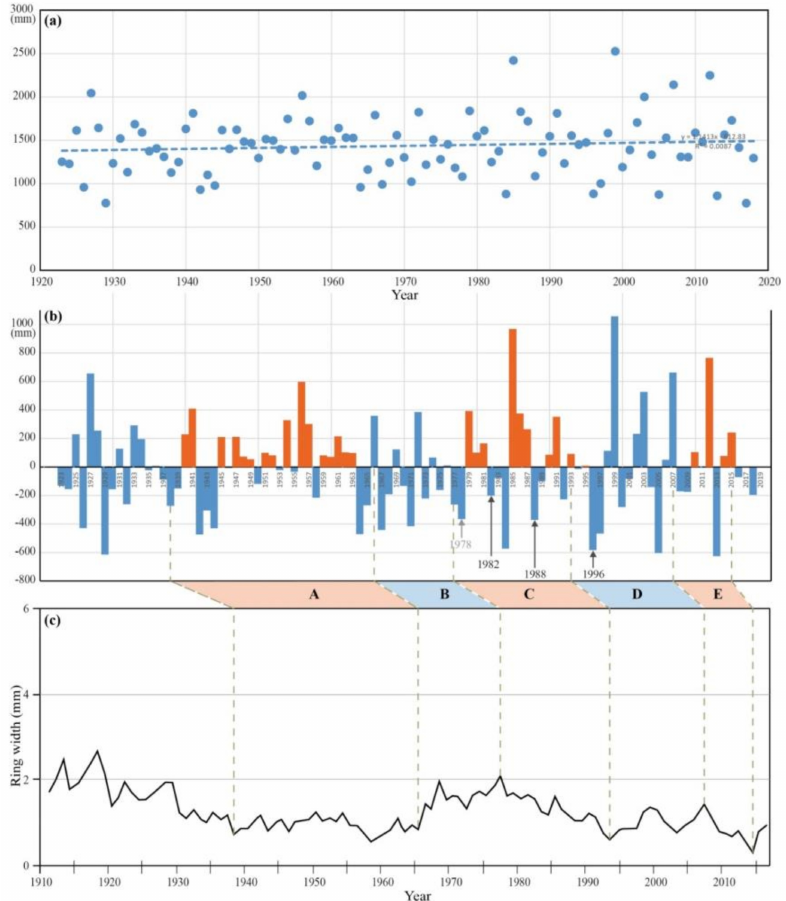
Figure 7. ( a ) Annual precipitation recorded at the Jeju Meteorological O ffi ce from 1923 to 2018 (modified from Reference [25]). ( b ) Annual precipitation deviation from the blue dashed regression line in panel (a). Black arrows show the time of the lowest growth rate of the Korea firs obtained from the dendrochronological analysis by Koo et al. [8]. The low growth rate of the Korean firs occurred after long-term persistence of the high rainfall. The period of above-average precipitation that persisted is shown with orange bars. ( c ) Master chronology established from tree-ring analysis for 10 living firs at Yeongsil in Mt. Halla (after Reference